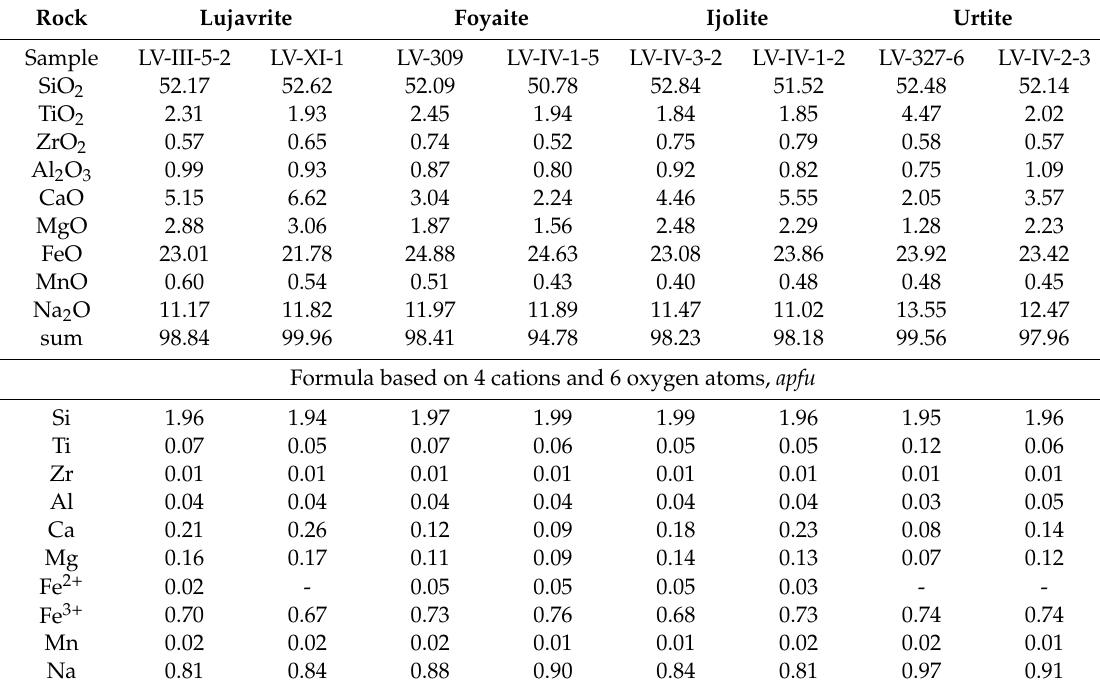
Table 6. Representative microprobe analyses of clinopyroxenes from the Layered complex, wt.%. Rock Lujavrite Foyaite Ijolite Urtite Sample